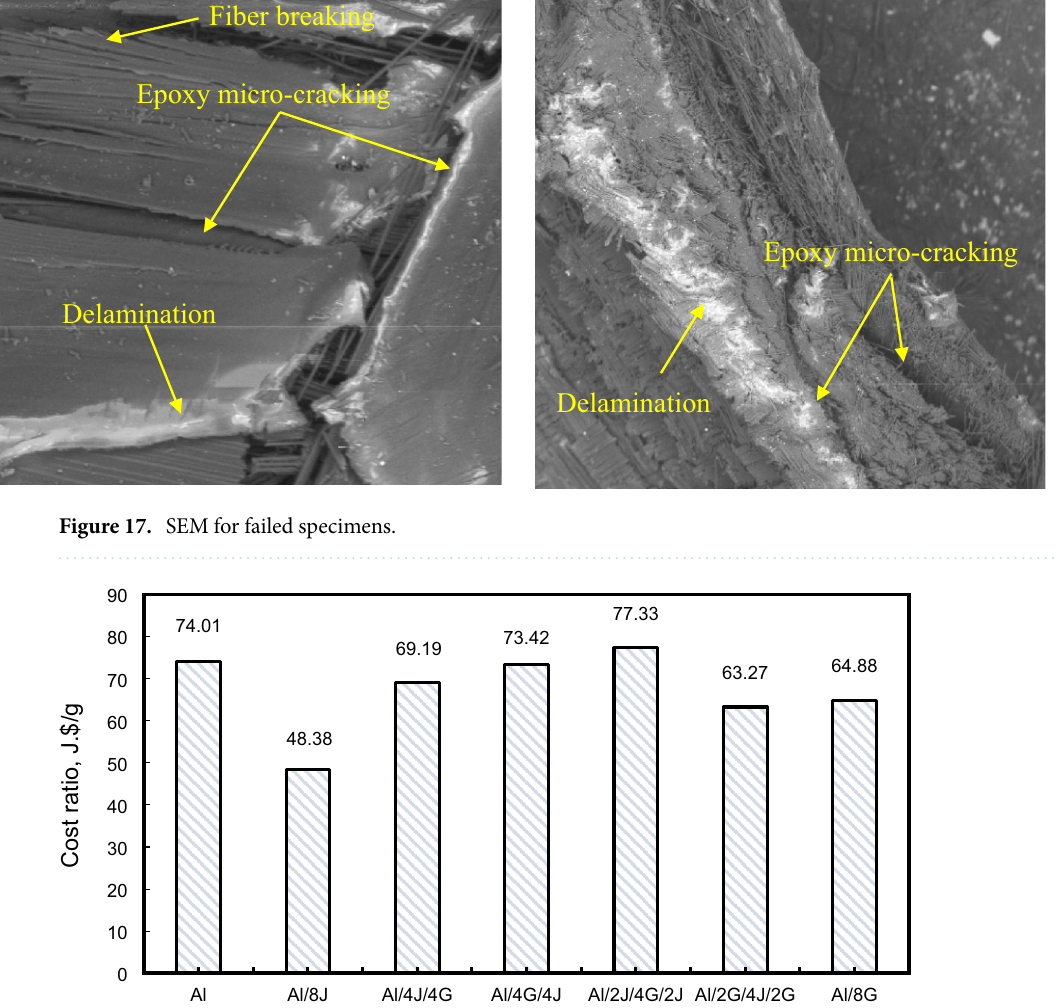
Figure 18. Cost ratio of the studied hybrid